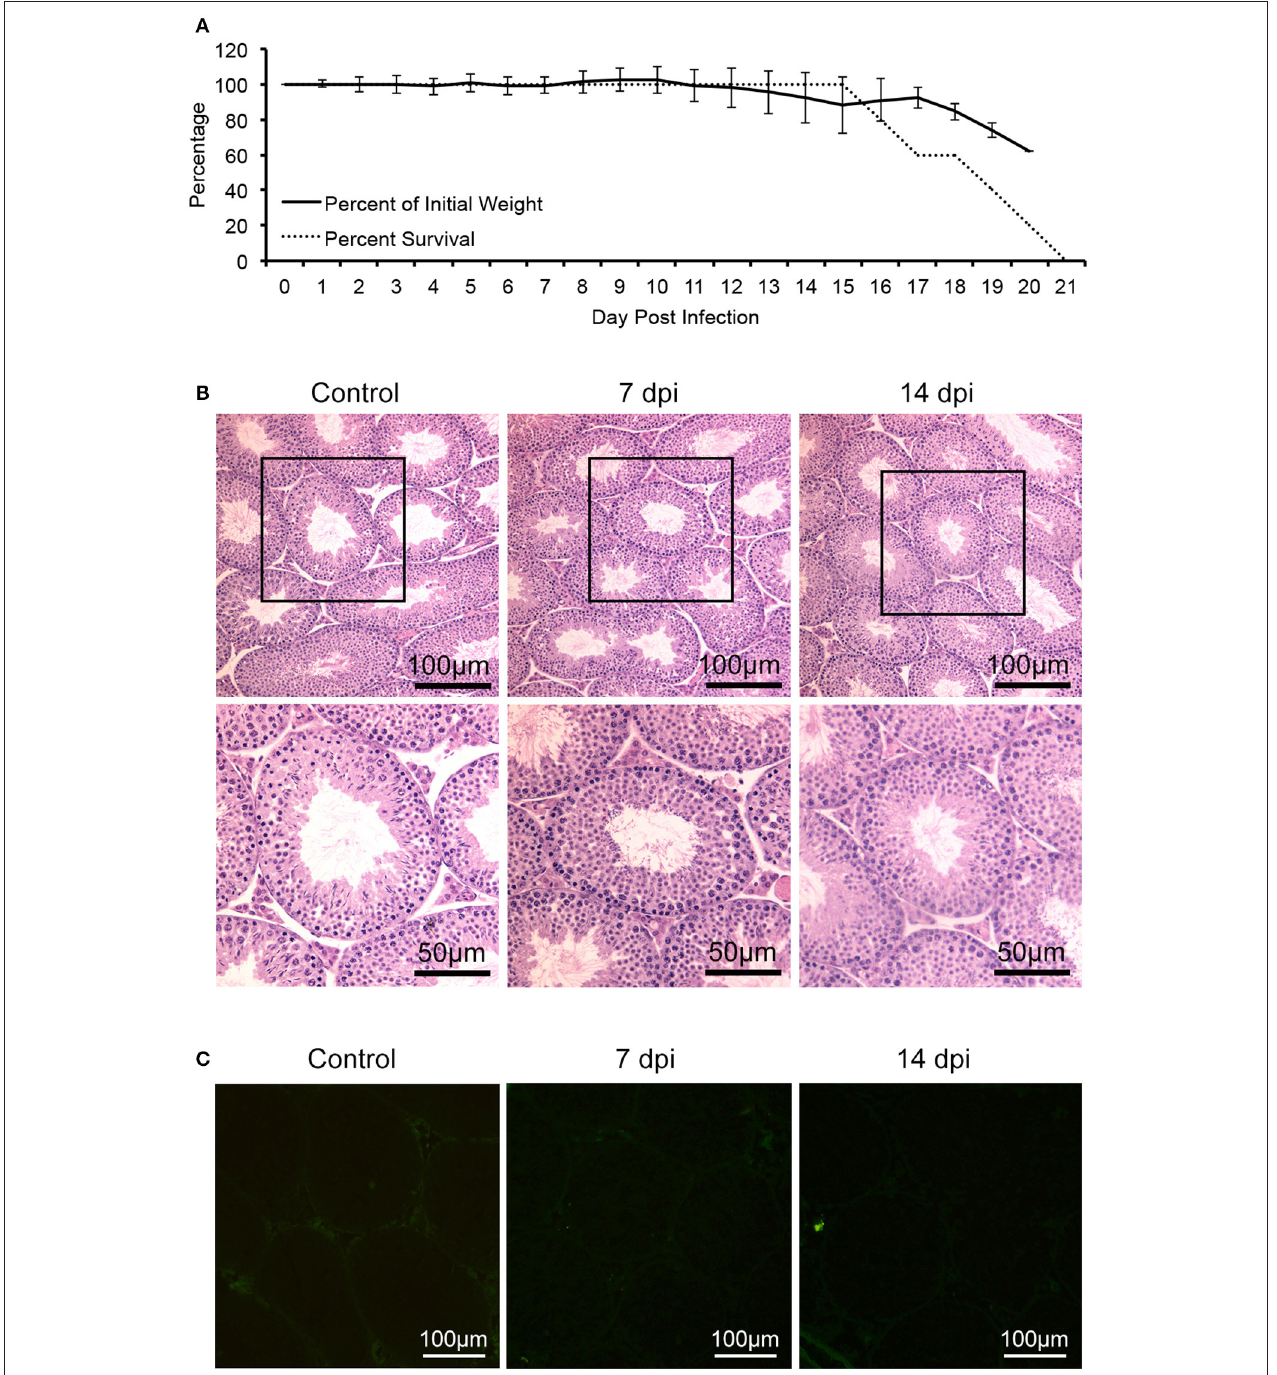
FIGURE 2 | Characterization of AG6 mice challenged with 10 5 pfu of DENV-2. Control mice were injected with PBS. (A) Changes of bodyweights and survival rate after infected with DENV-2 in male AG6 mice ( n = 5). (B) Histopathological changes of testis from DENV-2-infected AG6 mice at different time points as indicated or control mice. (C) Analysis of DENV-2 antigens in testis from DENV-2-infected AG6 mice at different time points as indicated or control mice.